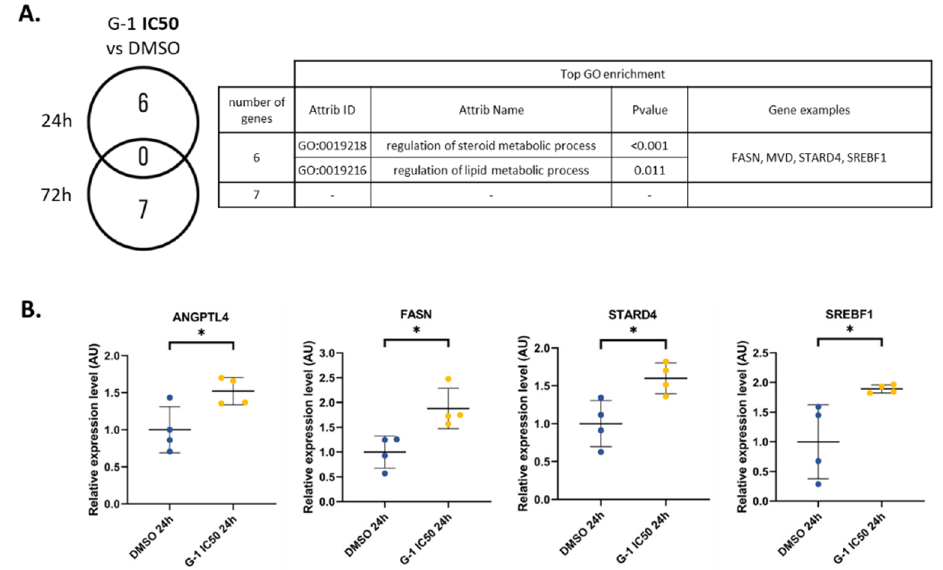
Figure 4. Dual effect of G-1 altering lipid metabolism and nuclear division pathways. ( A ) Number of vehicle versus G-1 IC50 (644.8 nM) DEGs and table of associated functions at 24 h and 72 h. ( B ) RT-qPCR analysis of the FASN , STARD4 , ANGPTL4 , and SREBF1 expressions in the RADH87 primary GBM cell line after 24 h of G-1 IC50 (562.5 nM) exposure. Data are presented as the mean ± SD. Significance level was determined using t -tests, where * indicates p < 0.05; n = 4.